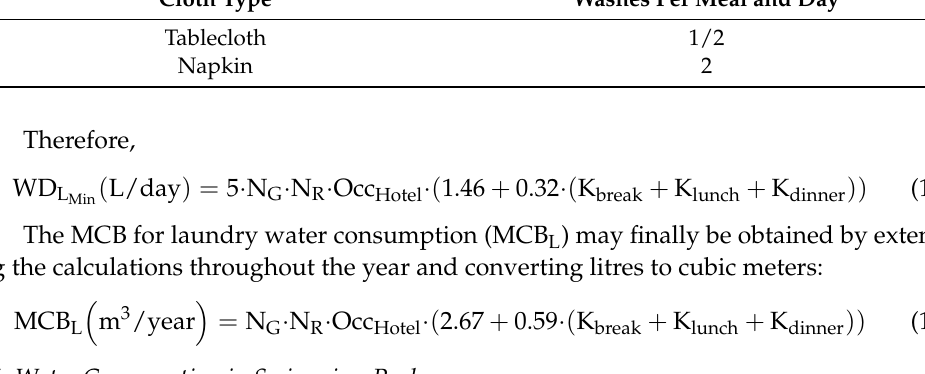
Table 12. Average washes per meal and day for each cloth in restaurants. Cloth Type Washes Per Meal and